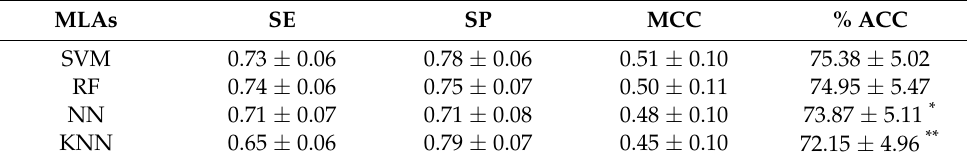
Table 1. Performance of selected ML models trained in amino acids composition. MLAs SE SP MCC % ACC SVM 0.73 ± 0.06 0.78 ± 0.06 0.51 ± 0.10 75.38 ± 5.02 RF 0.74 ± 0.06 0.75 ± 0.07 0.50 ± 0.11 74.95 ± 5.47 NN 0.71 ± 0.07 KNN 0.65 ±